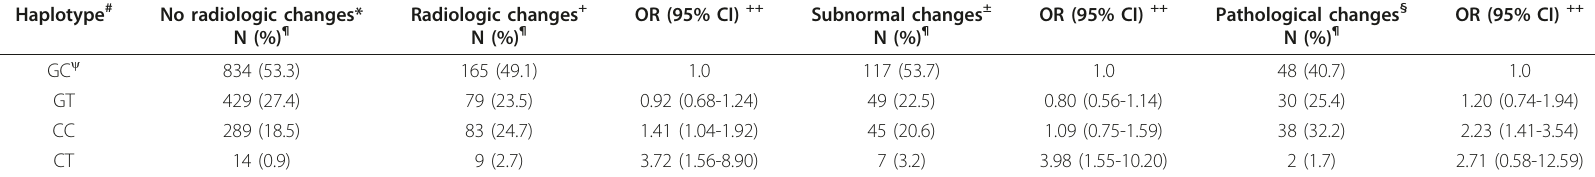
Table 5 Distribution of SERPINE2 haplotypes according to the existence and severity of panlobular emphysematous changes Haplotype